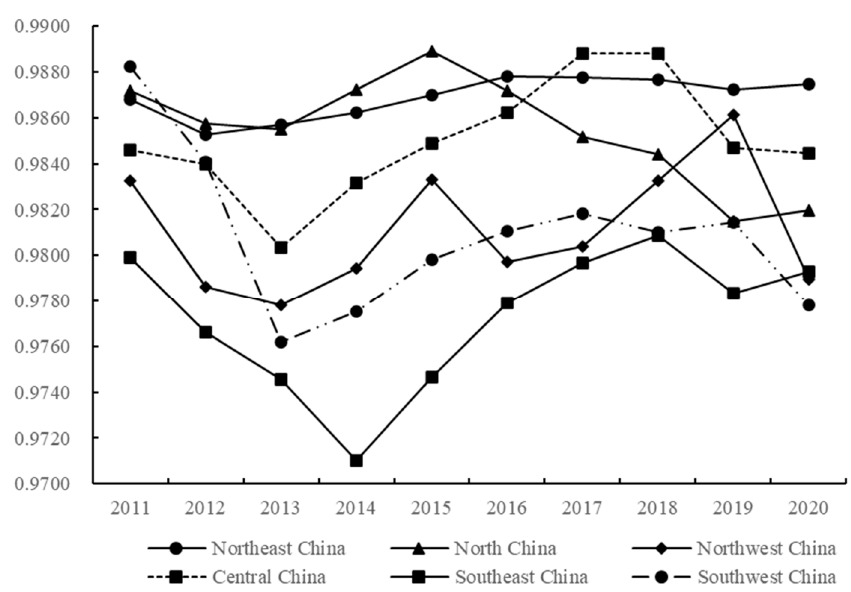
Figure 8. Annual technical efficiency of hog production in different regions of China from 2011 to 2020.